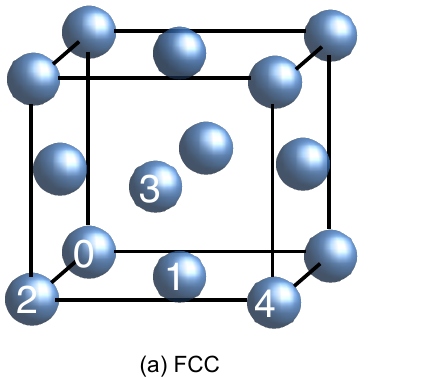
Figure 1. First four coordination shell numbers in fcc lattice ( a ) and the atomic schematics of the L1 2 -A 3 B intermetallic compound ( b ). The Arabic numerals 1, 2, 3, and 4 on the sphere of ( a ) present the coordination shell indexes 110, 200, 211, and 220, respectively, while "0" is the reference site. The positions of B atoms are indicated with golden spheres, while the positions of A atoms are indicated with blue spheres in ( b